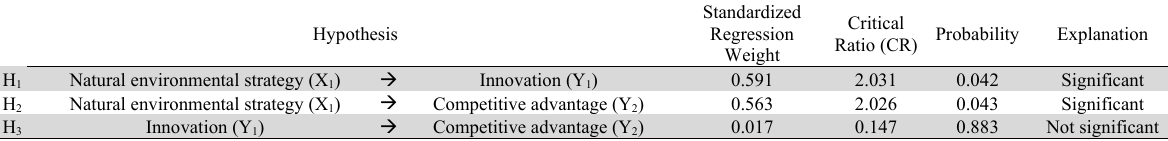
Hypothesis Testing